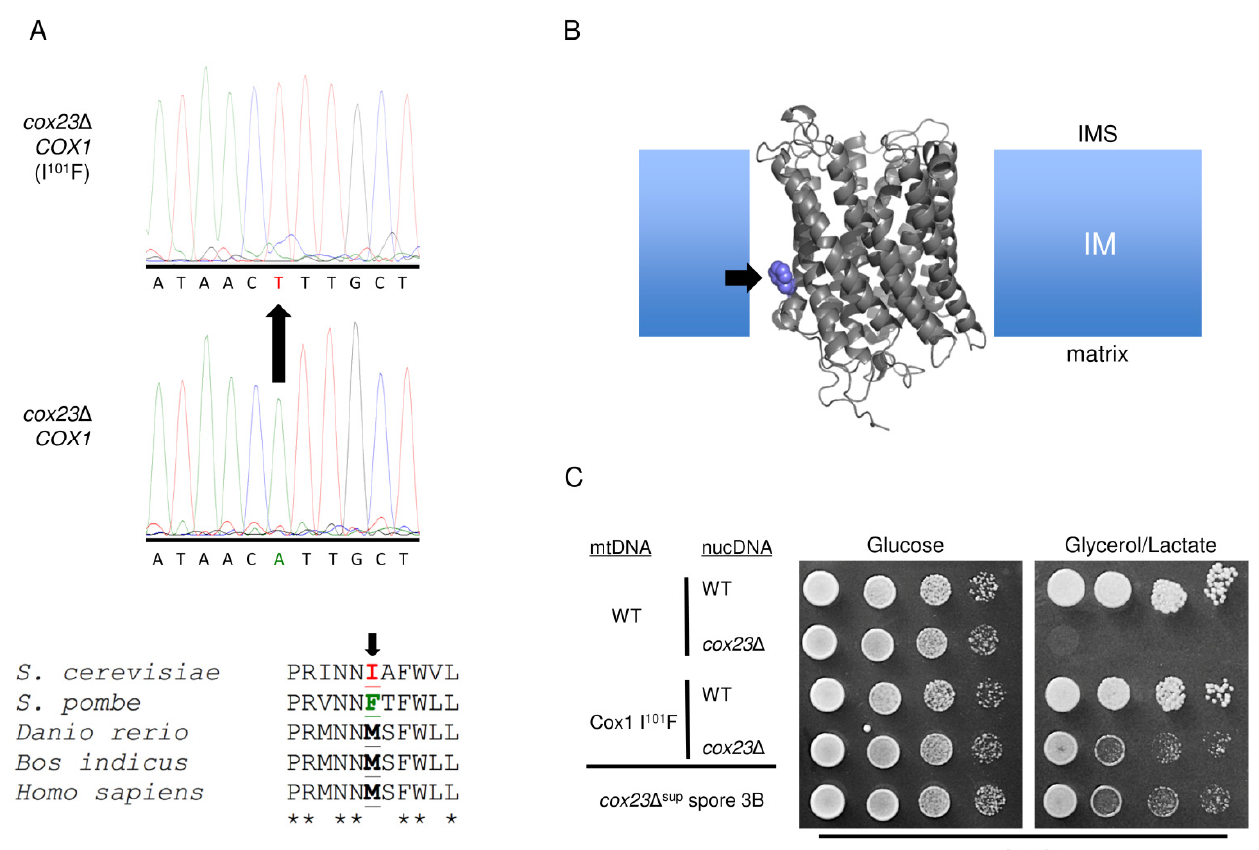
FIGURE 4: Identification of Cox1 I 101 F as the cox23 Δ suppressor. (A) Cox1 ORF cDNA was isolated by RT-PCR. Sanger sequencing led to the identification of an A → T mutation causing an Ile to Phe substitution in Cox1 at position 101 that curiously is wild-type in S. pombe (which lacks COX23 in its genome). (B) Probable location of the Cox1 mutation in the inner mitochondrial membrane based on sequence alignment to the Bos taurus crystal structure (1OCC.pdb). (C) Drop test on YPD and YPGL of Cox1 WT or I 101 F-bearing haploid cells with or without introduced cox23 deletion (rows 1-4) compared to the cox23 Δ spore known to contain Cox1 I 101 F (bottom, row